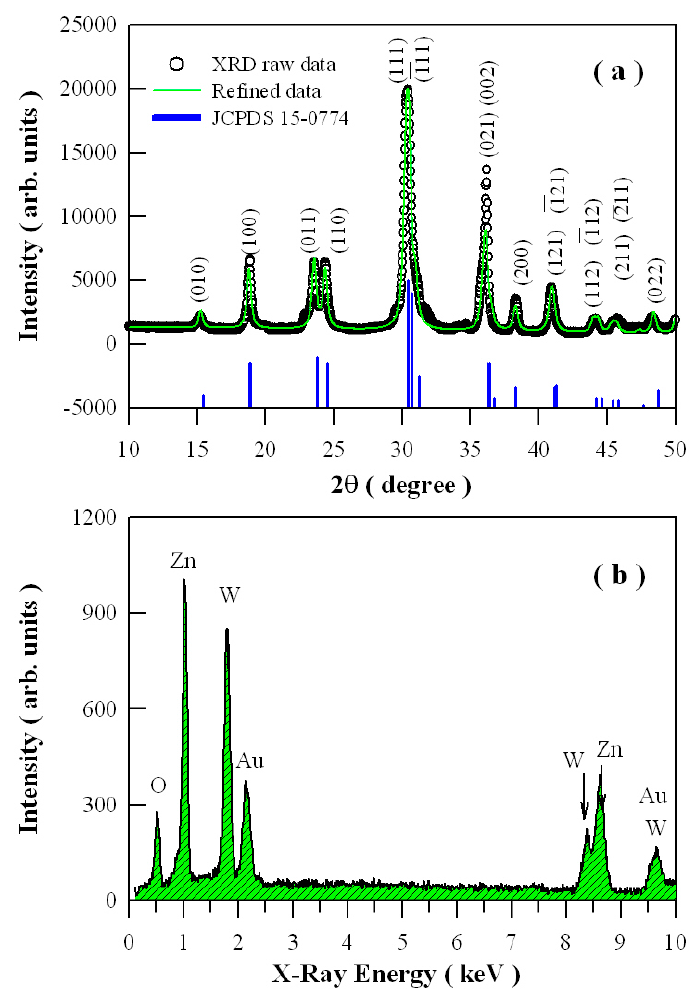
Figure 4. X-ray diffraction (XRD) curve ( a ) and energy-dispersive X-ray spectroscopy (EDX) spectrum ( b ) of ZnWO 4 nanoplates.